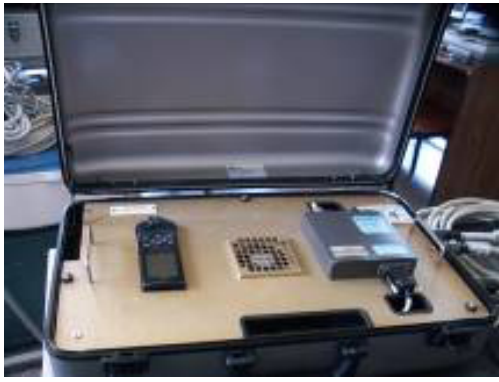
Figure 2. LIBRA remote unit